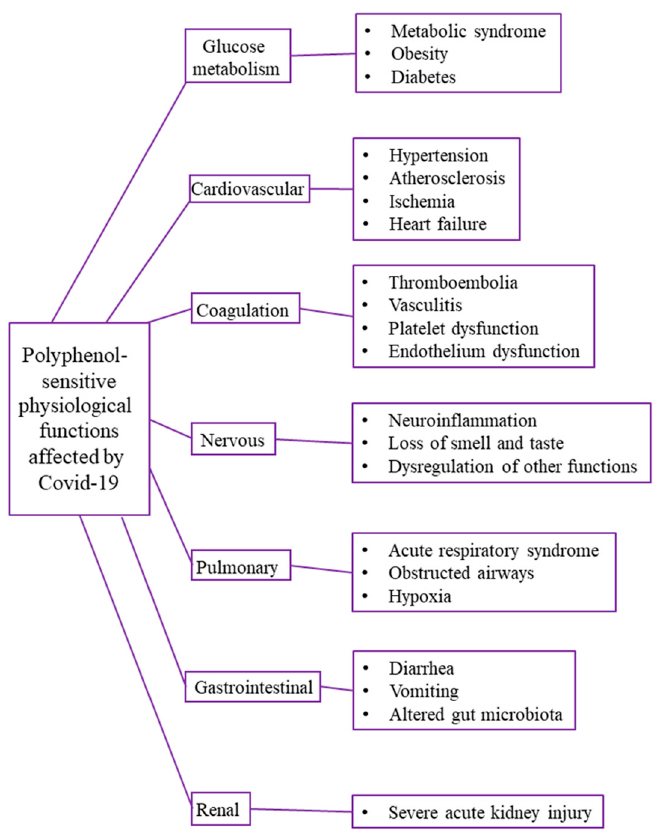
Figure 7. Physiological functions affected by COVID-19 and related diseases which the consumption of polyphenols can ameliorate.